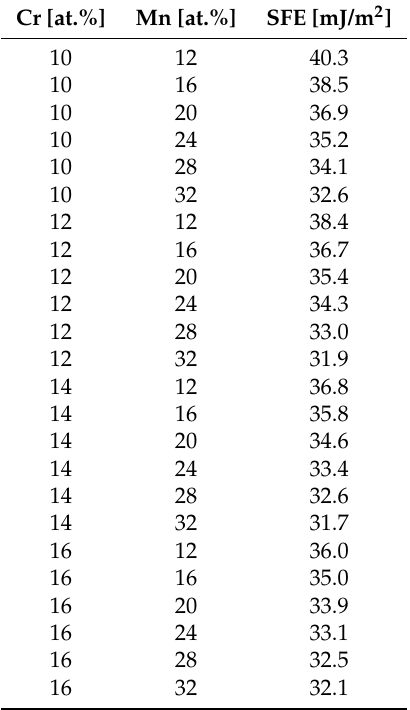
Table A2. Austenitic steels, their chemical composition and respective SFE obtained in DFT calculations at 300 K, data belong to Figure 5b.